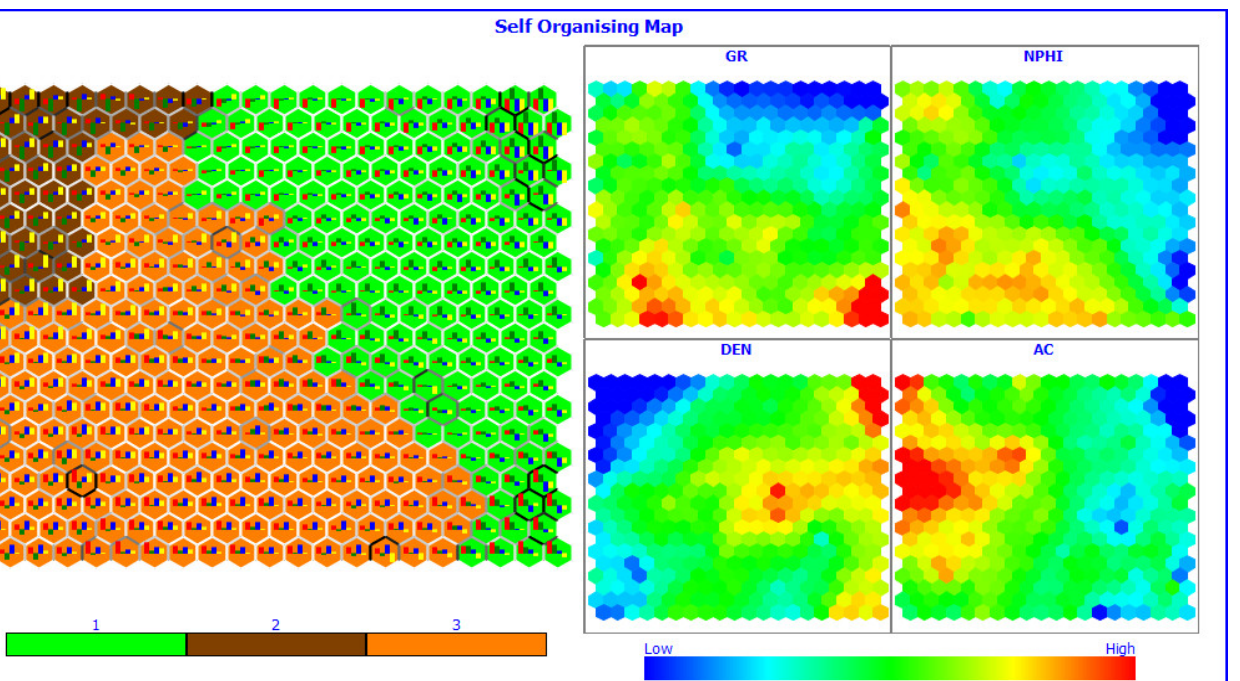
Figure 10. Indicating the distribution of the SOM facies vertically in reservoir intervals.